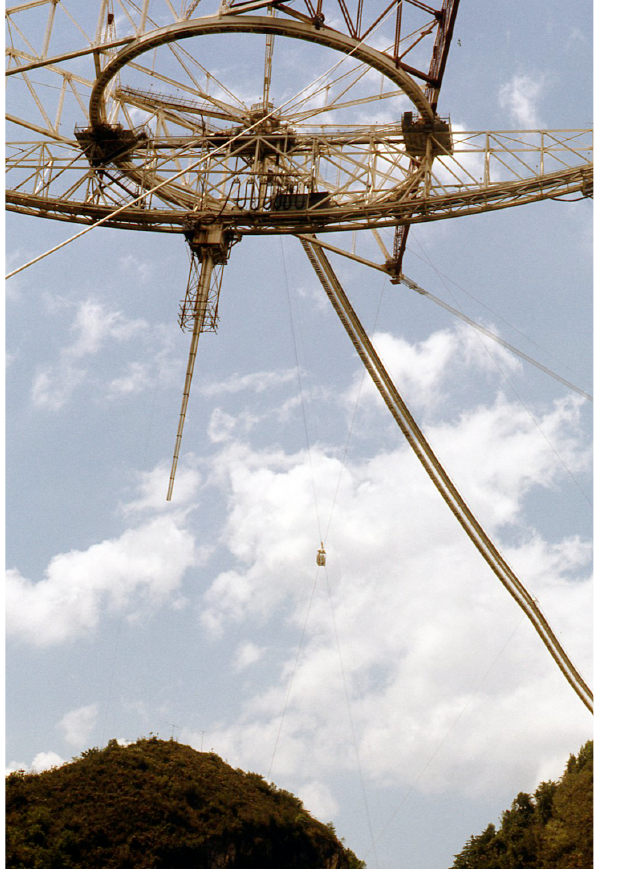
Figure 5. A picture from 13 May 1971 showing carriage house 1 (CH1) with the 40MHz radar feed system consisting of four Yagi antennas placed symmetrically around the original square cross- section 430MHz linefeed. Note the cable car giving convenient ac- cess to the platform relative to the catwalk which is located to the right and above the cable car in this photo. Photo courtesy of Cor- nell University and Arecibo